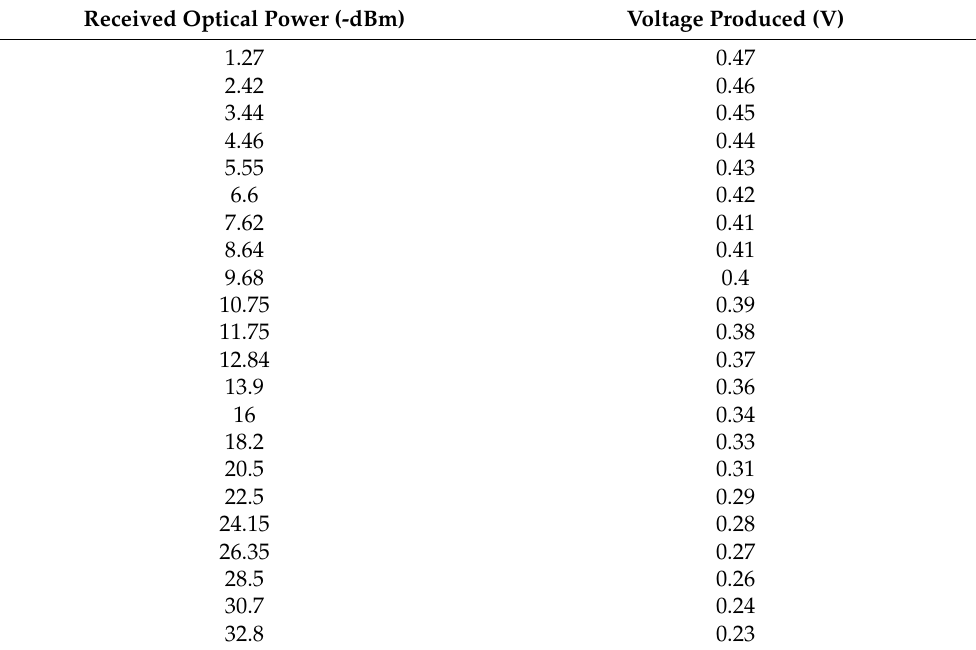
Table 3. Output voltage characteristic of the photo